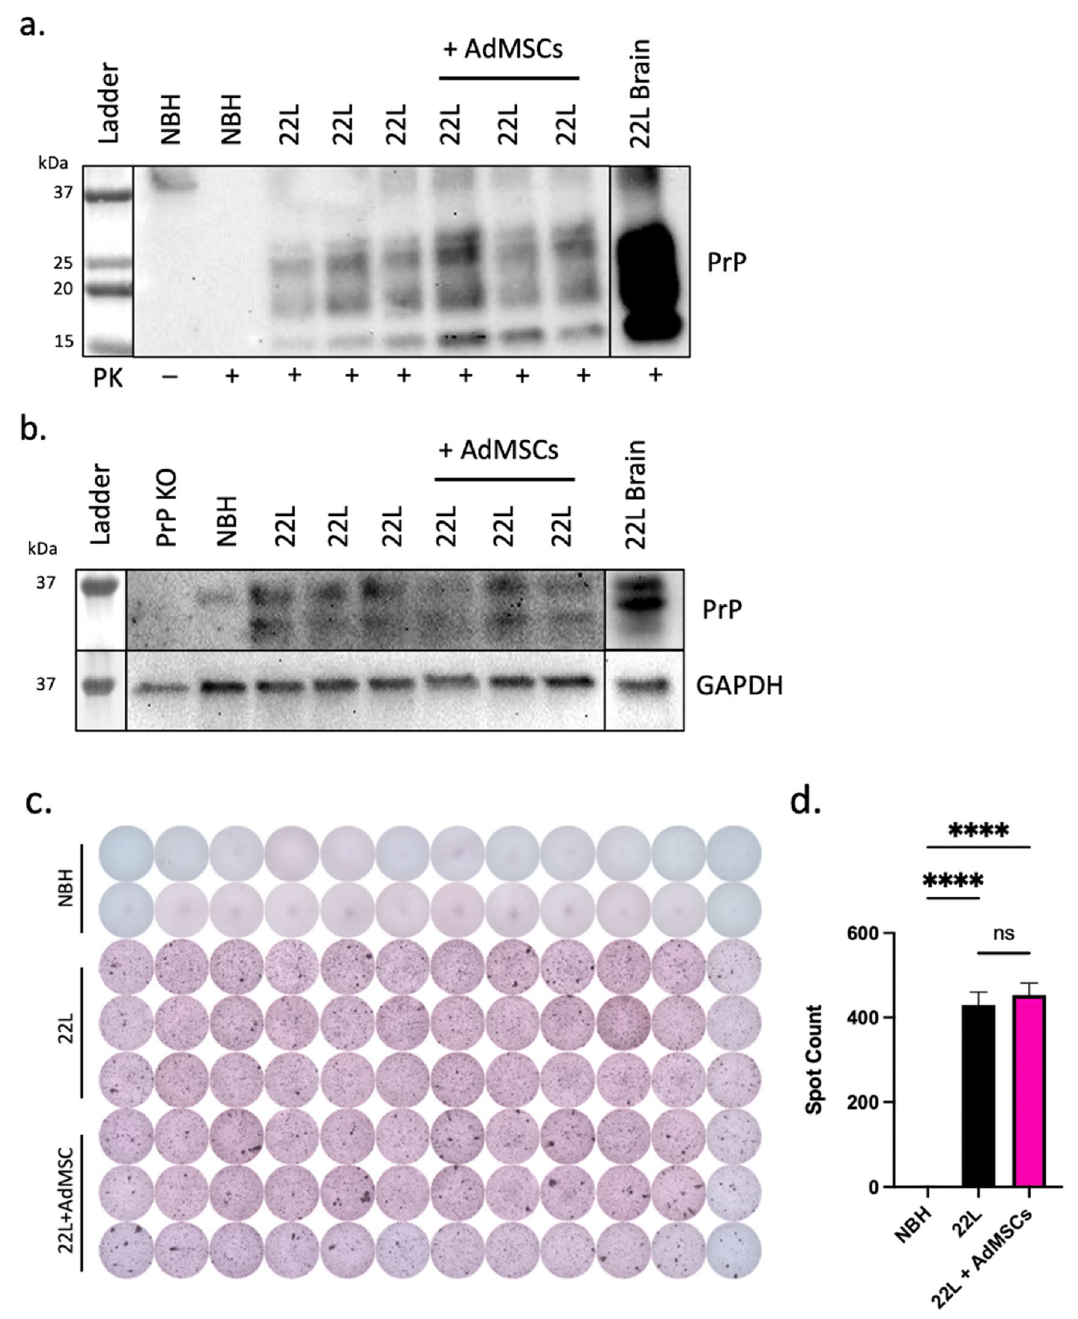
Figure 5. Protection against glial inflammation is independent of PrP Sc . Infected mixed glial cells were cocultured with AdMSCs and western blot was used to analyze ( a ) PrP Sc and ( b ) PrP C . 22L-infected brain homogenate positive control (lower exposure) in right-most lanes. ( c ) Scrapie cell assay was used to analyze PrP Sc spot counts. Representative image from three separate experiments. ( d ) Spot counts analyzed with One- way ANOVA and post-hoc Tukey test, error bars = SEM, **** p < 0.0001, ns = not